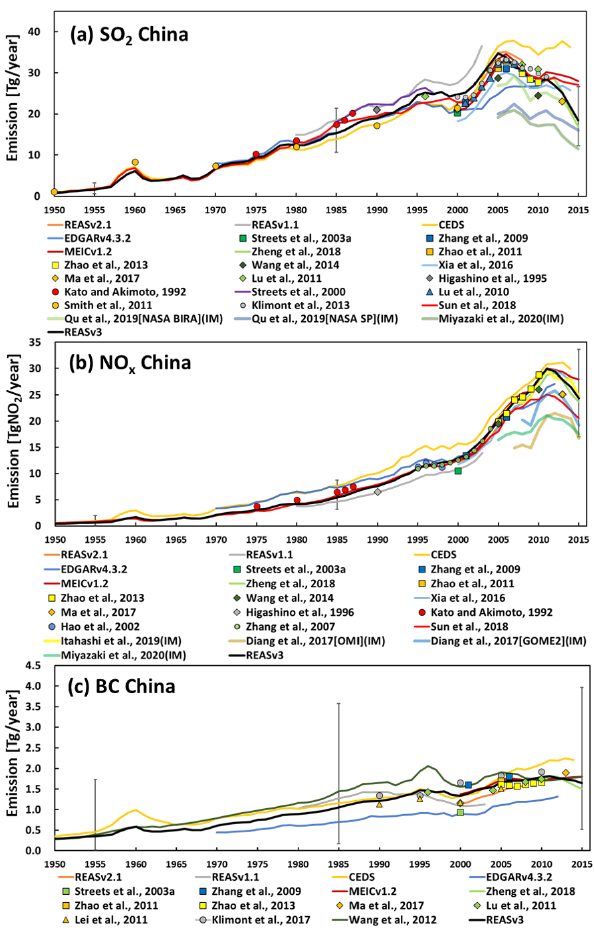
Figure 10. Comparison of (a) SO 2 , (b) NO x , and (c) BC emissions in China between REASv3 and other studies. Note that emissions from domestic and fishing ships were excluded from REAS series, CEDS, EDGARv4.3.2, and Higashino et al. (1996). IM means esti- mates by inverse modeling. Error bars indicate the uncertainty range of REASv3 in 1955, 1985, and 2015.